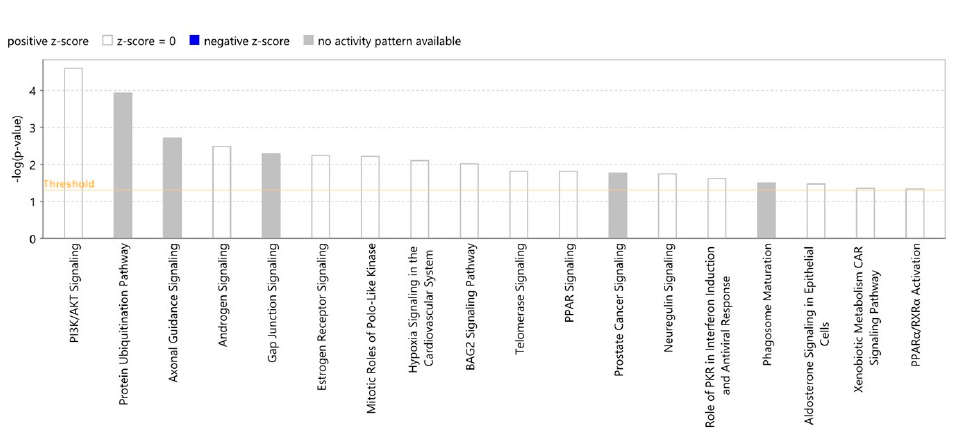
Figure 9. Canonical signaling pathways were predicted by using the proteomic data of 40 proteins in a panel of 55 NCI tumor cell lines and IPA™.